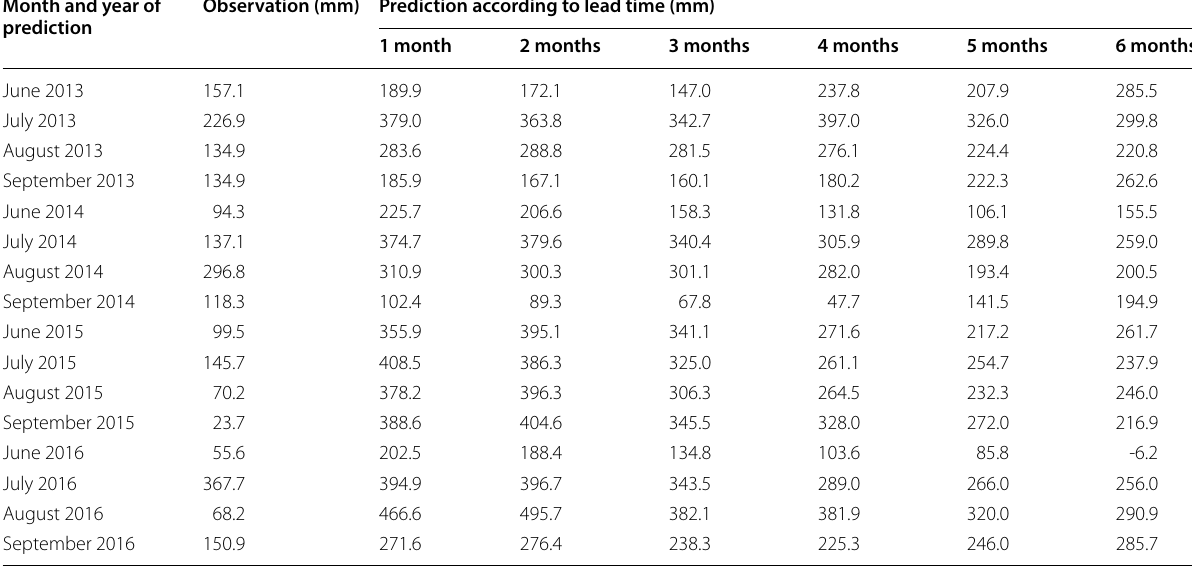
Table 7 Results of the precipitation prediction model based on teleconnection Month and year of Observation (mm) Prediction according to lead time (mm) prediction 1 month